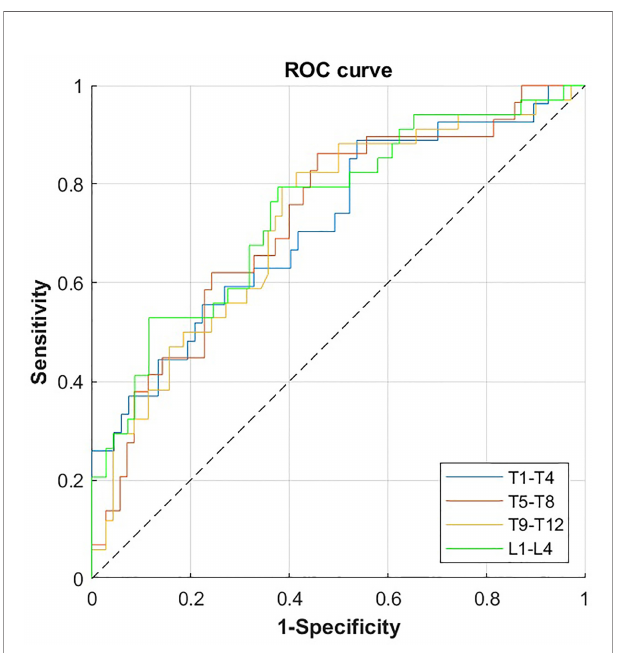
FIGURE 3 | AUC (blue line) with 95% con fi dence intervals (dashed line) by vertebral height, averaged over four consecutive